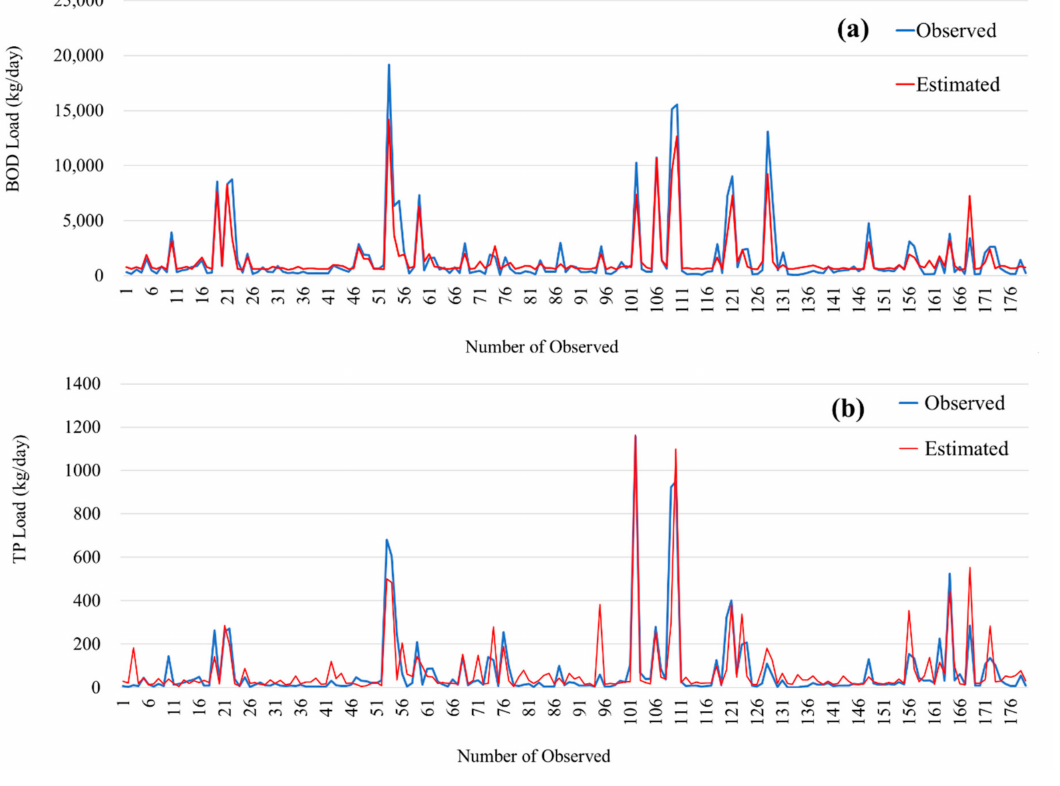
Figure 10. Comparison between observed and estimated values: ( a ) BOD; ( b )